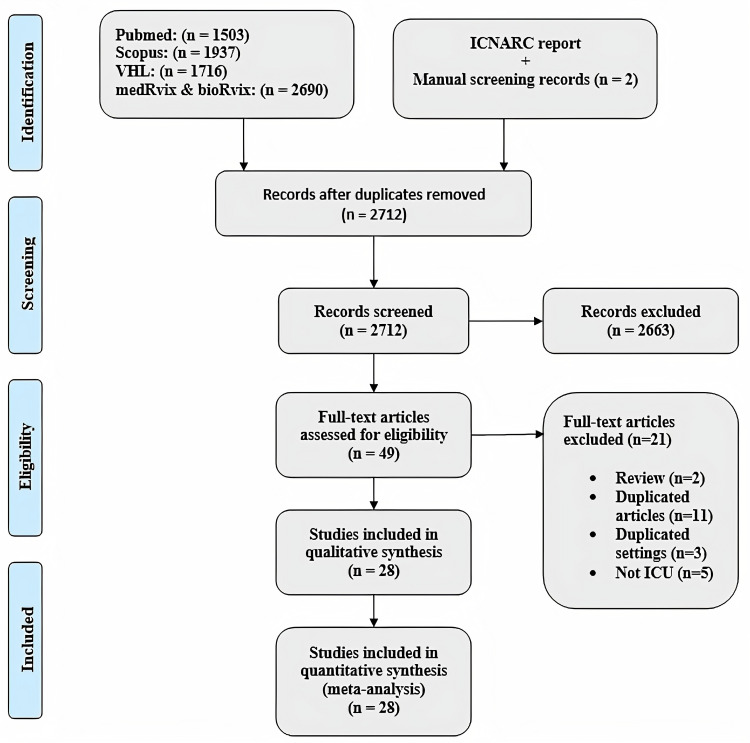
PRISMA flow diagram.PRISMA diagram depicting study selection process.